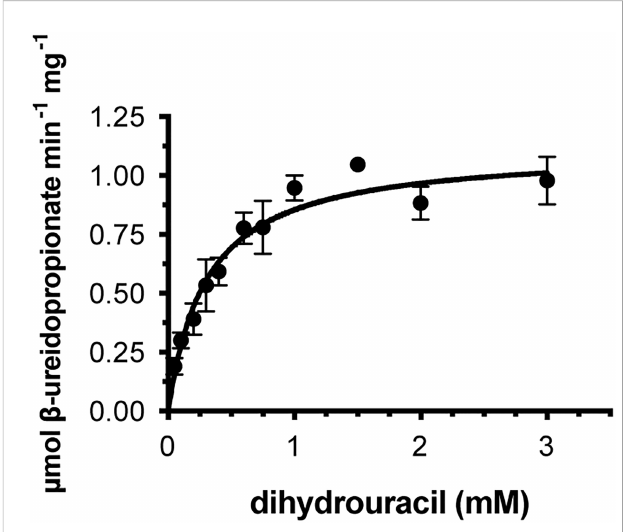
FIGURE 3 Steady state kinetics of puri fi ed recombinant OsDHP-T1. Saturation curve for dihydrouracil. Data were fi tted to the Michaelis-Menten equation, v = (V max · [S])/(K m + [S]).